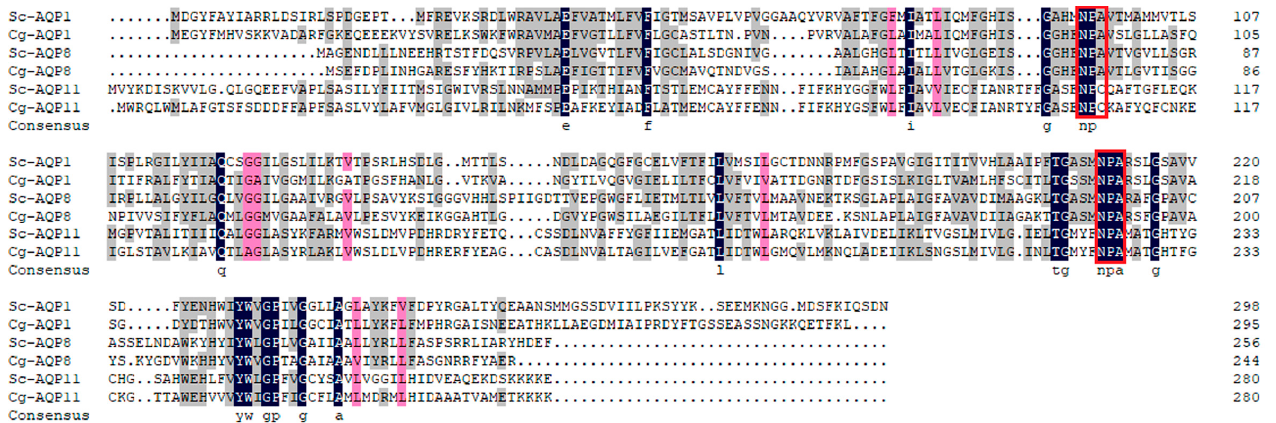
Table 3. Amino acid identity and similarity of Sc ‐ AQP1, Sc ‐ AQP8, and Sc ‐ AQP11 putative peptides as compared with other AQP1, AQP8, and AQP11 molecules.